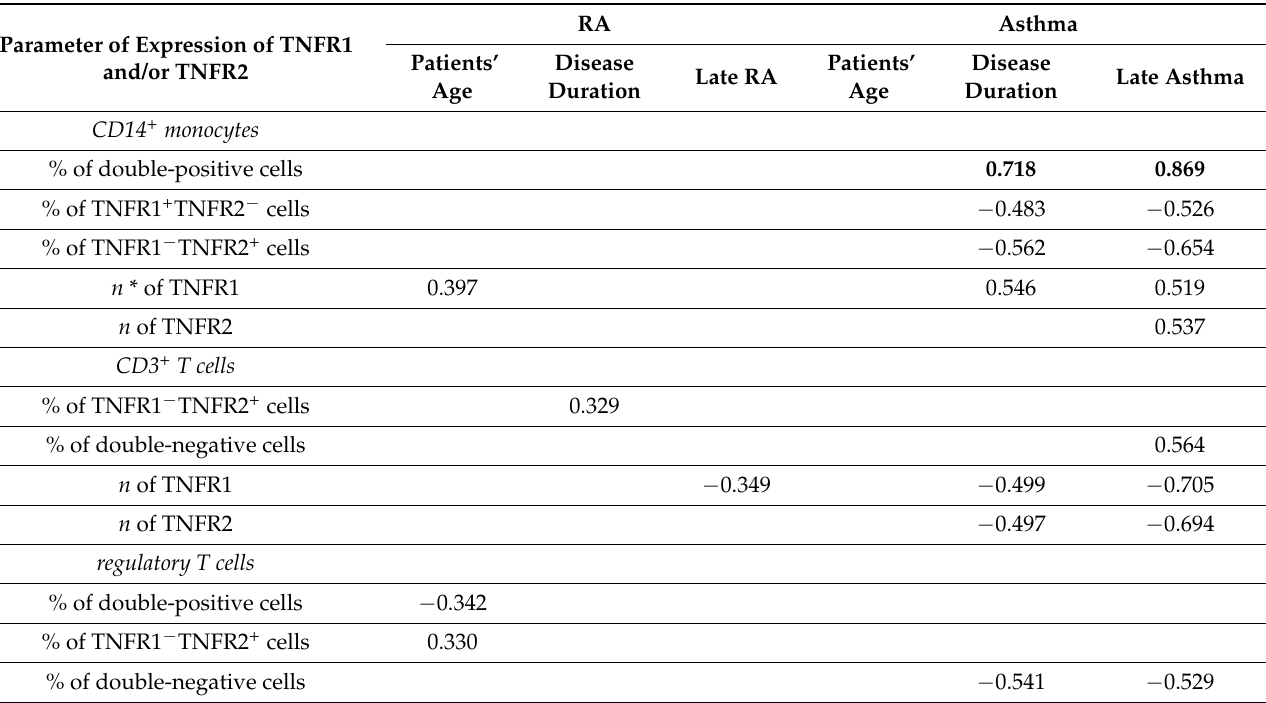
Table 2. Correlations between disease duration and patterns of expression of TNF receptors in immune-cell